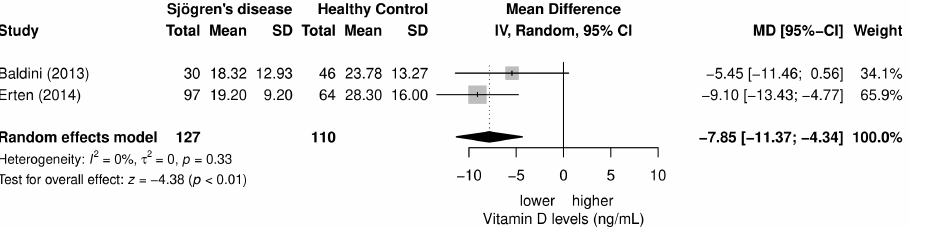
Figure 5. Subset meta-analysis of vitamin D levels in female patients with SD in comparison to fe- male controls [21,22]. controls